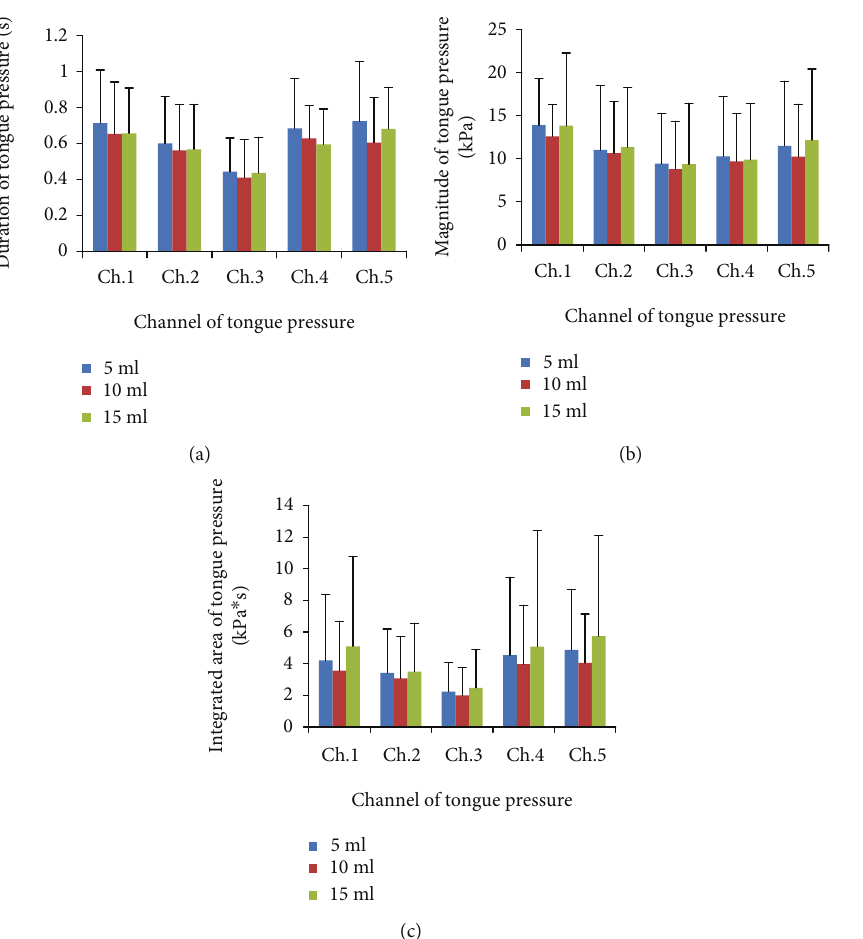
Figure 3: E ff ects of bolus volume on tongue pressure parameters. (a), Duration of tongue pressure. (b), Magnitude of tongue pressure. (c), Integrated area of tongue pressure. Ch. 1 – Ch. 5, Channel 1 to Channel 5. Data were expressed as the mean ± standard deviation